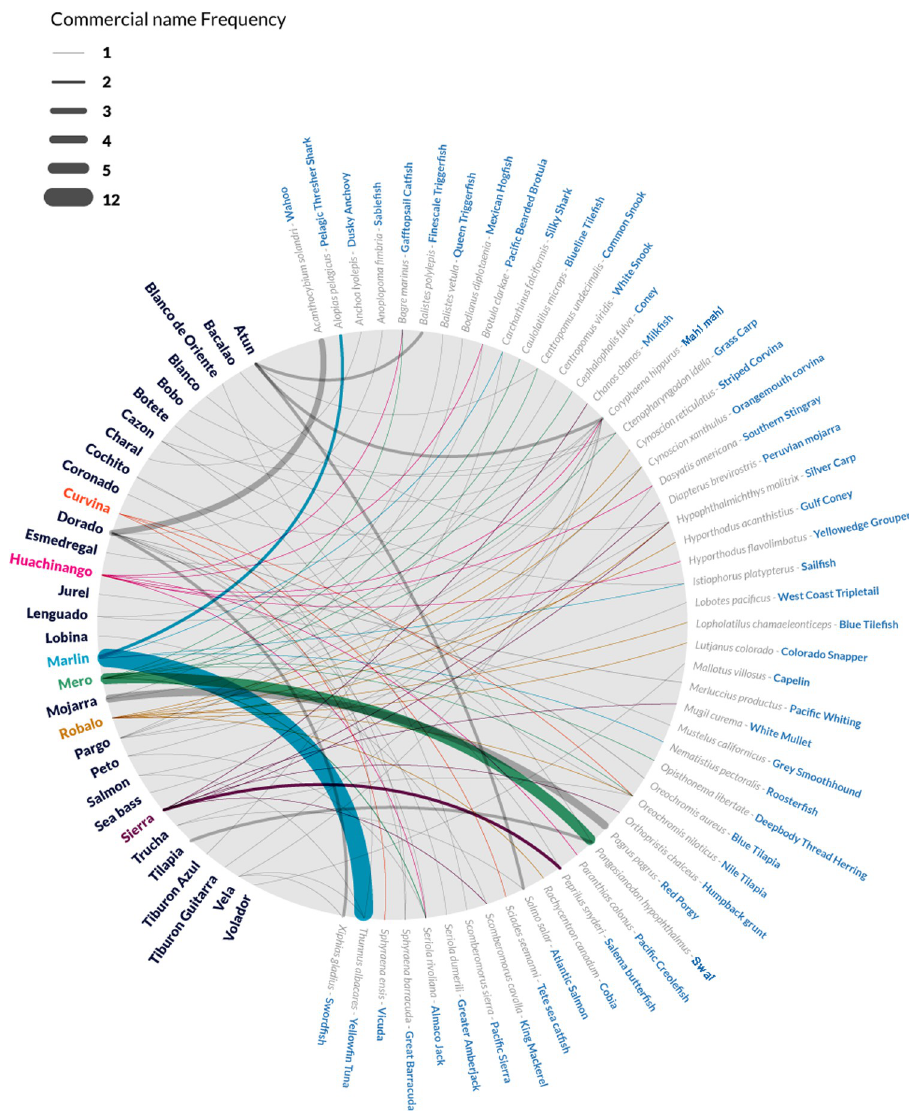
Fig 1. Alluvial plot showing the patterns of 116 instances of mislabeling found in Mexico, displayed as a network connecting 53 species used as substitutes for 32 commercial names that created 90 unique combinations under which samples were mislabeled. Line widths represent the frequency of a given mislabeling combination (thickest line = 12 events). The six commercial names with the highest frequency of mislabeling are shown with distinct colors.